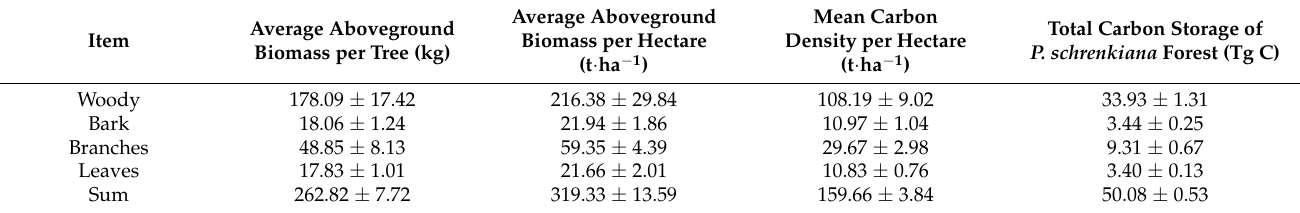
Table 2. Aboveground biomass, carbon density, and carbon storage in P. schrenkiana forest in the Tianshan Mountains. Average Aboveground Item Biomass per Tree